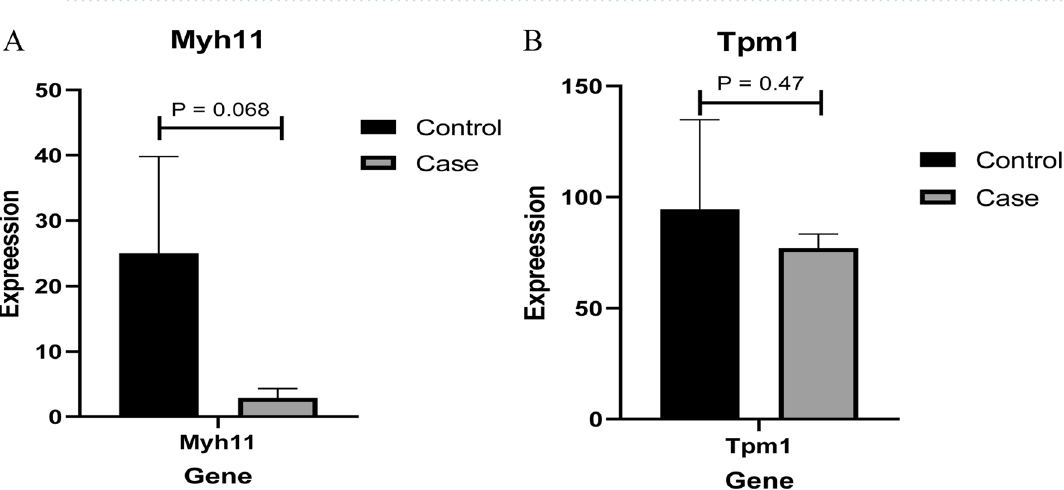
Figure 9. Electronic verification of differentially expressed proteins at the mRNA level. (A) The mRNA expression result of myosin heavy chain 11 (MYH11); (B) The mRNA expression result of tropomyosin 1 (TPM1). Control and case groups represent the standard group and the high-fat and high-energy feed groups, respectively. P < 0.05 was considered to indicate a statistically significant